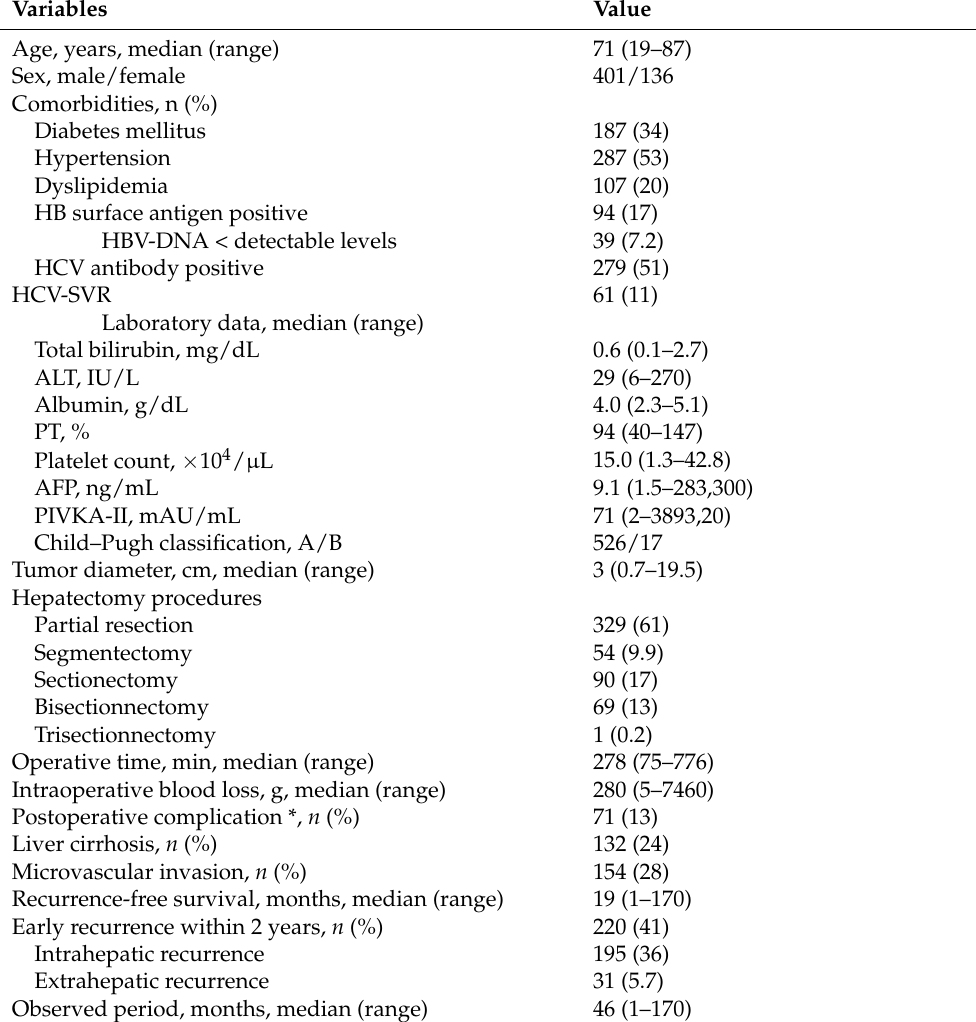
Table 1. Background characteristics and surgical outcomes of the study